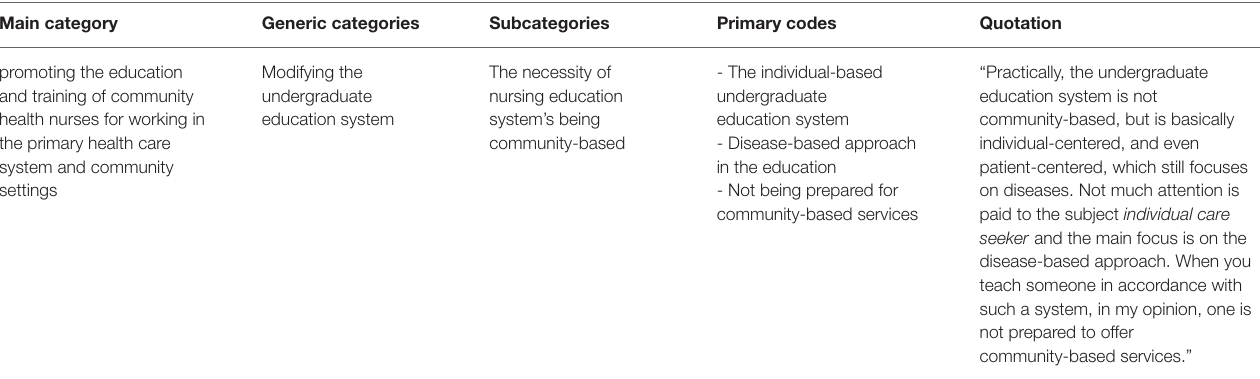
TABLE 2 | An example of data